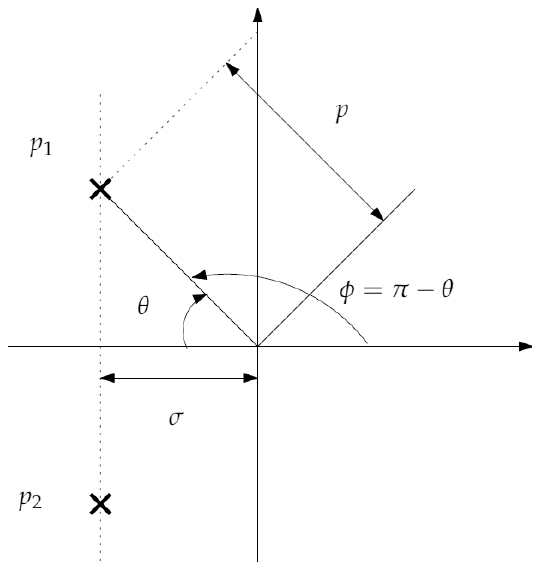
Figure 4. Location of the poles of the closed outer